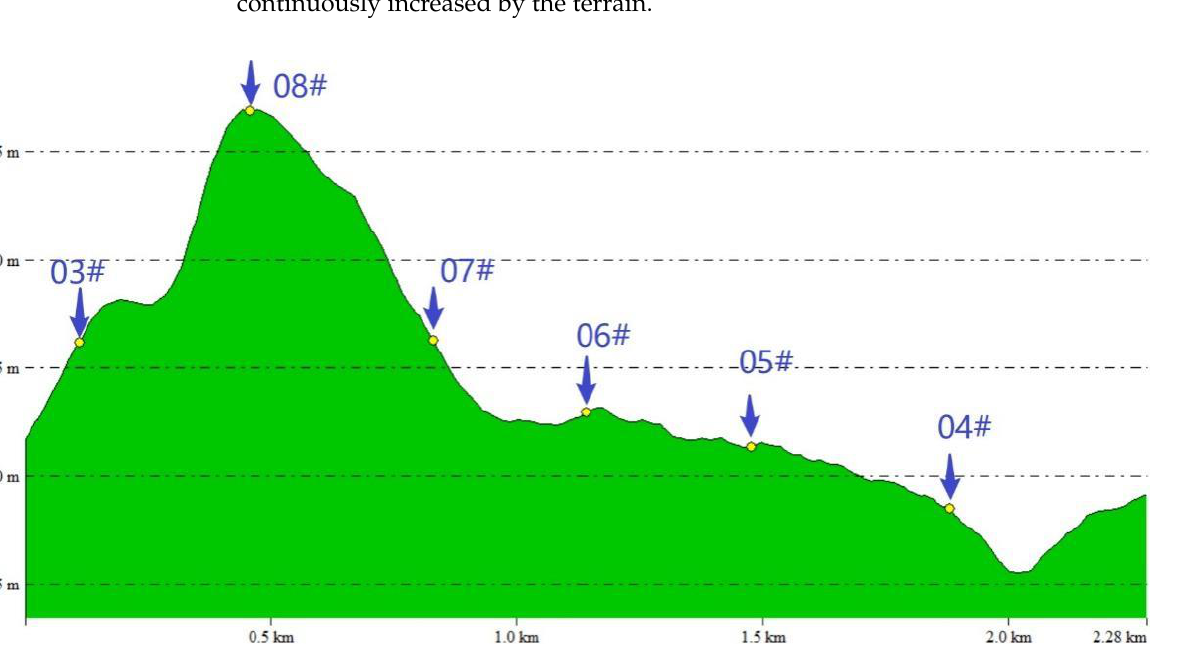
Figure 9. Profile of ridge in northeast region of wind farm.